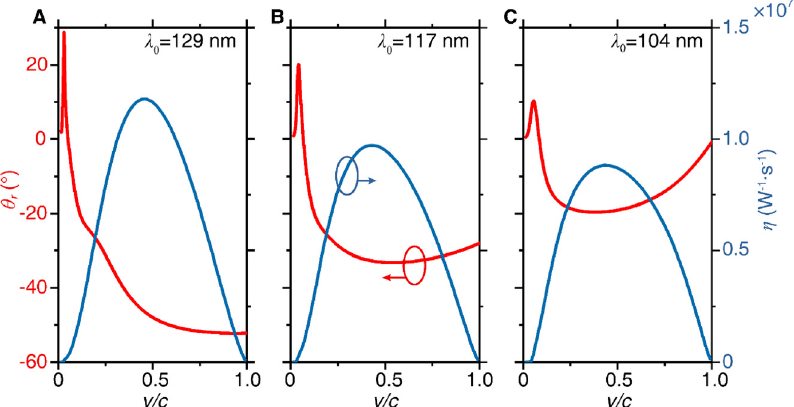
117 nm in (B), and 104 nm in (C)